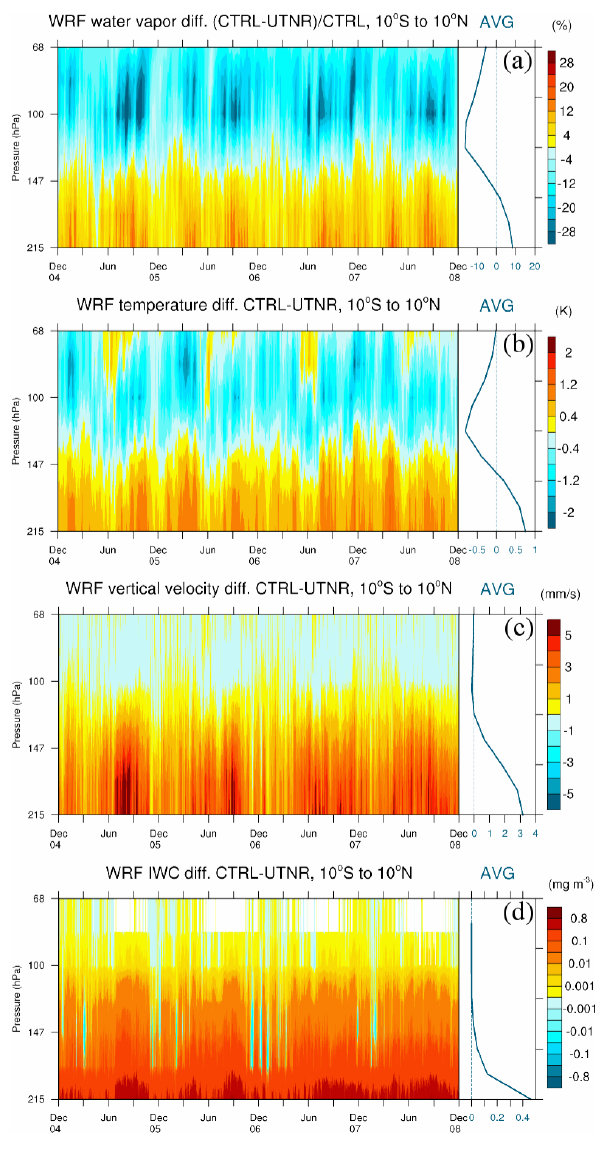
Figure 5. (left panel) Height-time cross section of inner tropical (10°S-10°N) mean daily differences between the WRF CTRL and UTNR simulations for (a) water vapor difference (%) relative to the WRF CTRL run; (b) temperature difference (K); (c) vertical velocity difference (mm s -1 ); (d) IWC difference (mg m -3 ). (right panel) Vertical profiles of 4-year mean differences in left panel.